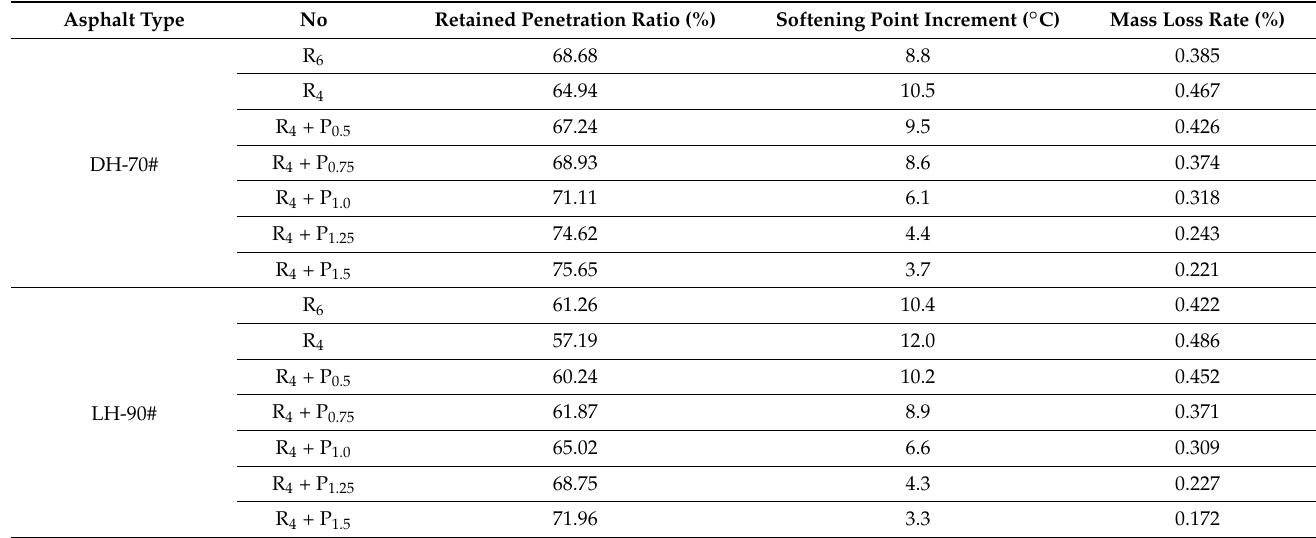
Table 7. Performance changes of PPA–SBR modified asphalt before and after